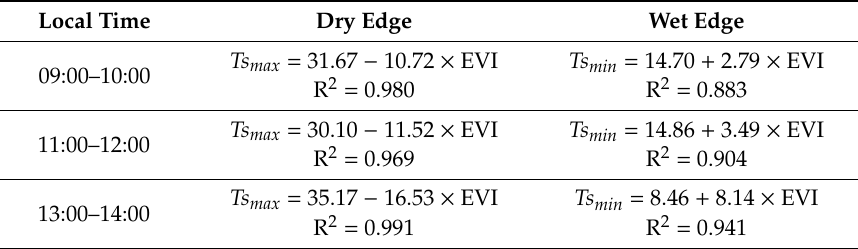
Table 4. Slope and o ff set of dry and wet edges estimated from STAEFM TIR on 18 January 2019. EVI, enhanced vegetation